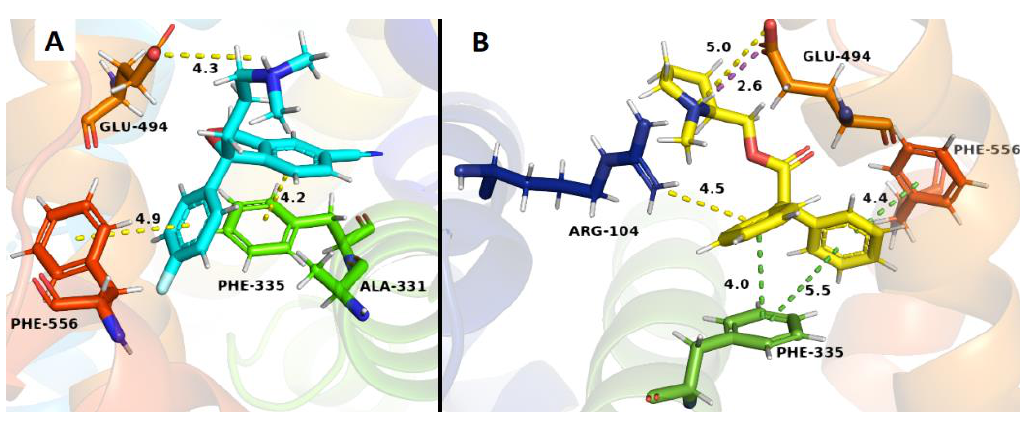
Figure 8. Binding modes of S-citalopram co-crystal ( A ) and compound 20 ( B ) to the human SERT. The cyan ligand denotes S-citalopram and the yellow ligand denotes compound 20. Dotted lines correspond to the different interactions in the ligand – receptor complexes.